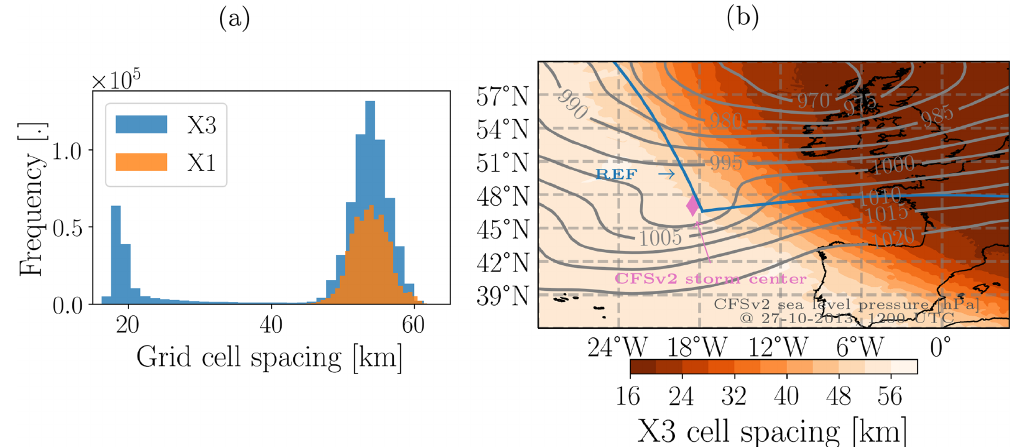
Figure 4. (a) Histogram of grid cell distances in the quasi-uniform X1 and variable-resolution X3 MPAS mesh configuration. (b) Spatial distribution of grid cell spacing in the X3 mesh configuration together with the sea level pressure contours and storm center location obtained from CFSv2 at 27 October 2013, 12:00UTC as well as the “REF” domain from WRF. The presence of grid spacing below 18km in X3 is a consequence inherent to MPAS’ SCVT mesh discretization which requires deviations in grid cell sizes of individual cells also below the target to maintain SCVT properties (see e.g. Du et al., 2003; Ringler et al., 2008 for details). Table 3. Overview of MPAS scenarios and their configuration. Used abbreviations: KF: Kain-Fritsch (Kain, 2004), GF: Scale–aware Grell– Freitas (Grell and Freitas, 2014), NT: New Tiedtke (Zhang et al., 2011; Zhang and Wang, 2017), TMS: Thompson non-aerosol aware (Thompson et al., 2008), WSM6: WRF Single–Moment 6-Class (Hong and Lim, 2006), MYNN: Mellor–Yamada–Nakanishi–Niino (Nakan- ishi and Niino, 2009), YSU: Yonsei University Scheme (Hong et al., 2006), MM5: Revised MM5 similarity scheme (Jiménez et al., 2012), RRTMG: Rapid Radiative Transfer Model for General Circulation Models (Iacono et al., 2008). Attribute X1-CPKF X1-CP X1-MESO X3-CPKF X3-CP X3-MESO Mesh Physics 54km 54km 54km 54–18km 54–18km 54–18km Cumulus KF GF NT KF GF NT Microphysics TMS TMS WSM6 TMS TMS WSM6 Land surface Noah (Niu et al., 2011; Yang et al., 2011) Boundary layer MYNN MYNN YSU MYNN MYNN YSU Surface layer MYNN MYNN MM5 MYNN MYNN MM5 Long-/shortwave